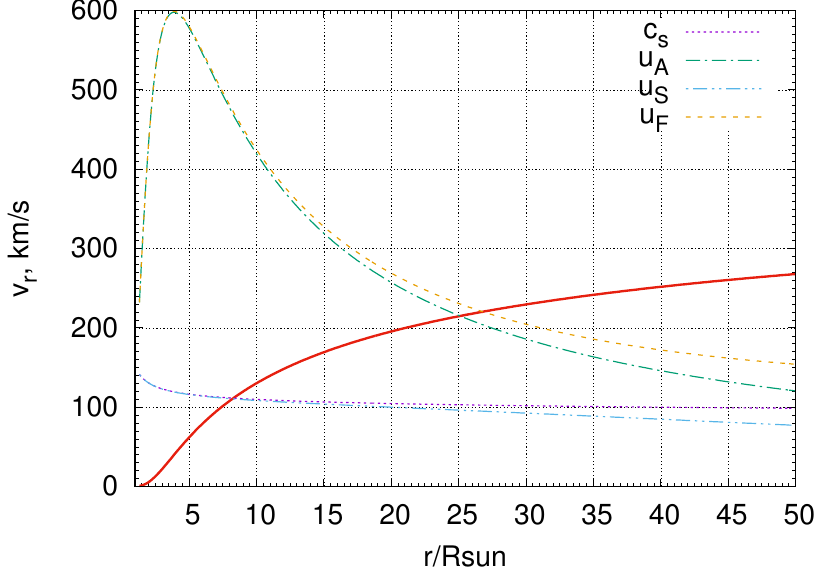
Figure 3. Distributions of the radial velocity v r (solid line), the speed of sound c s , the Alfvén velocity u A , as well as the slow u S and fast u F magnetosonic velocities depending on the radius r